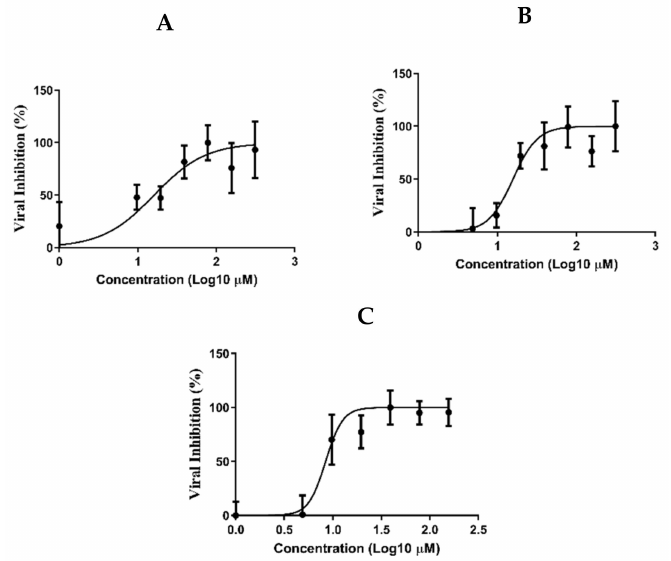
Figure 5. IC 50 of SIT ( A ), MEL ( B ), and combination of SIT-MEL ( C ) against SARS-CoV-2.